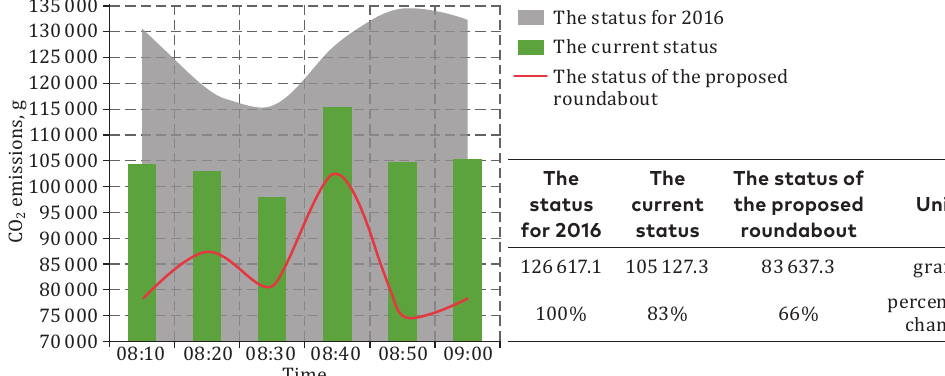
Figure 24. Carbon emission of vehicle-time change